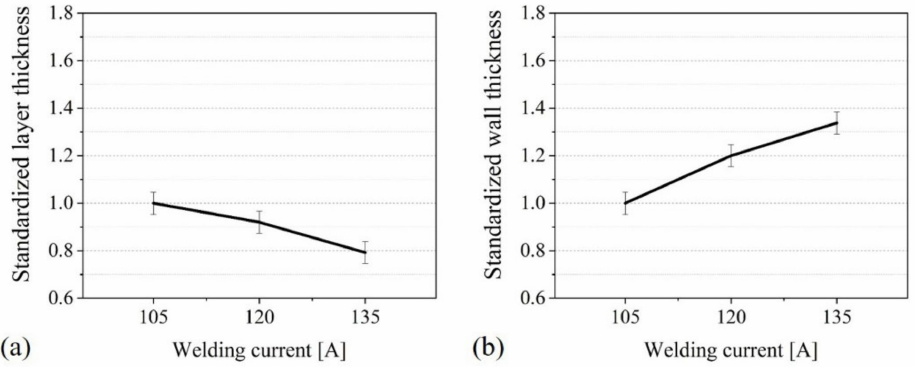
Figure 3. Effect of welding current on layer thickness ( a ) and wall thickness ( b ) (standardized representation).